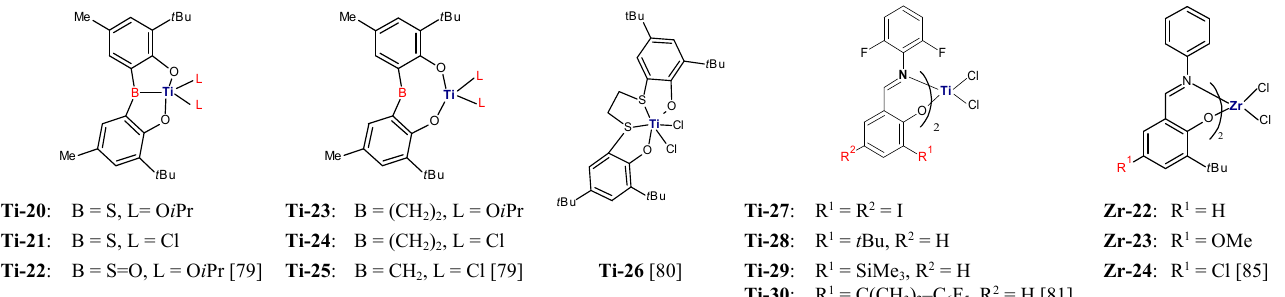
Figure 6. Titanium and zirconium complexes investigated as precatalysts for ethylene/styrene copolymerization [79–81,85].